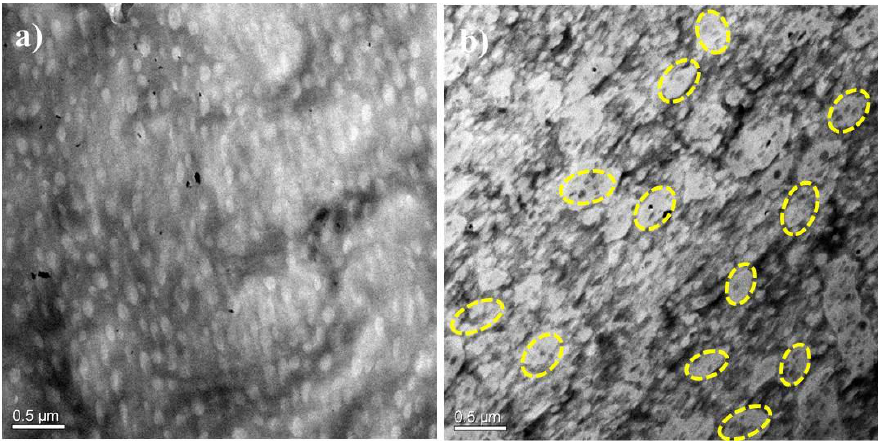
Figure 2. Transmission electron microscope (TEM) images of the PA12/PK blends ( a ) A8K2 and ( b ) A5K5. The bright area is the PK phase.